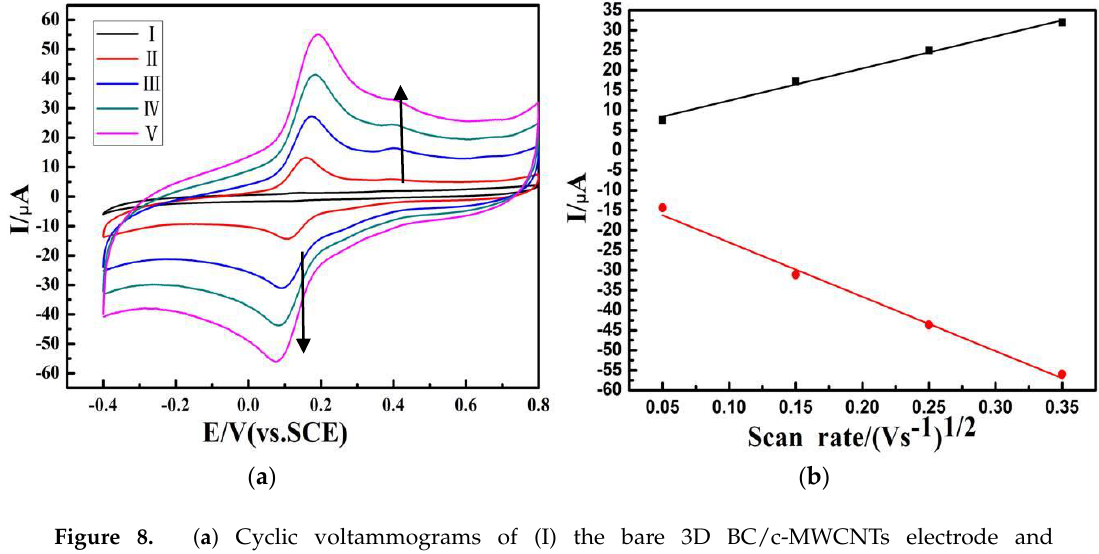
Figure 8. ( a ) Cyclic voltammograms of (I) the bare 3D BC/c-MWCNTs electrode and BC/c-MWCNTs/Lac electrode in a 0.1 M acetic acid/sodium acetate buffer solution (pH 5.5) at scan rates (mV s −1 ): (II) 50, (III) 150, (IV) 250, (V) 350; and ( b ) The inset is a plot of the oxidation and reduction peak currents vs. the scan rates.